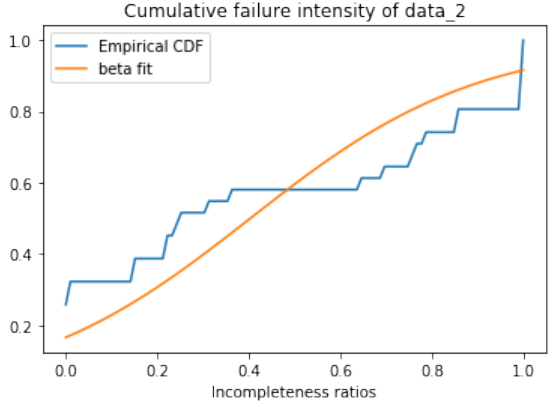
Figure 8. Empirical CDF on the fitted logistic distribution on NNDSS dataset.